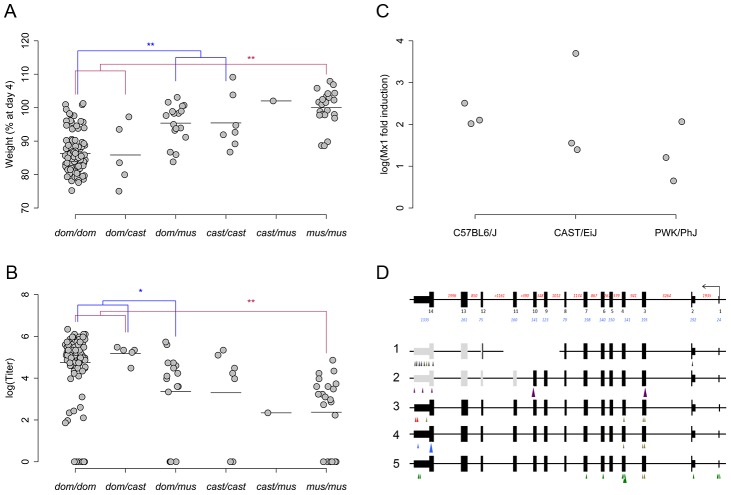
A novel Mx1 allele differentially impacts host response to influenza.The founder strain alleles at Mx1 were grouped based on their phenotypic effects into three functionally distinct classes corresponding to domesticus (dom: A/J, C57BL6/J, 129s1/SvImJ, NOD/HiLtJ and WSB/EiJ), castaneus (cast: CAST/EiJ) and musculus (mus: PWK/PhJ and NZO/ShILtJ). Points shown are individual pre-CC animals with these haplotypes, mean bars are shown for each class. These functionally distinct classes were separable based upon differences in (A) D4 weight and (B) Log titer, with the heterozygous classes showing intermediate phenotypes. Across the pre-CC population, homozygous dom animals had severe weight loss and high titers. Homozygous mus animals showed little weight loss and low titers. Homozygous cast animals showed little weight loss, but had intermediate viral titers. Brackets between groups represent significant differences (* = p<0.05, ** = p<0.003) based on Tukey's HSD. We found no difference by qPCR (C) in expression of Mx1 at 2 days post-infection following influenza infection in a strain from each of these three functional classes. By sequencing Mx1 (D), we were able to identify five haplotypes across the eight founder strains (Haplotype 1 = A/J, C57BL/6J, 129S1/SvImJ, NOD/HiLtJ; Haplotype 2 = WSB/EiJ; Haplotype 3 = PWK/PhJ; Haplotype 4 = NZO/HiLtJ; Haplotype 5 = CAST/EiJ). Arrows indicate locations of polymorphisms, with small arrows indicating non-coding changes, and large arrows indicating coding changes. Colors correspond to the founder strains having those polymorphisms (brown = multiple strains possess mutation). Grey exons indicate those not transcribed due to either deletion and frameshift, or insertion and early stop codon.